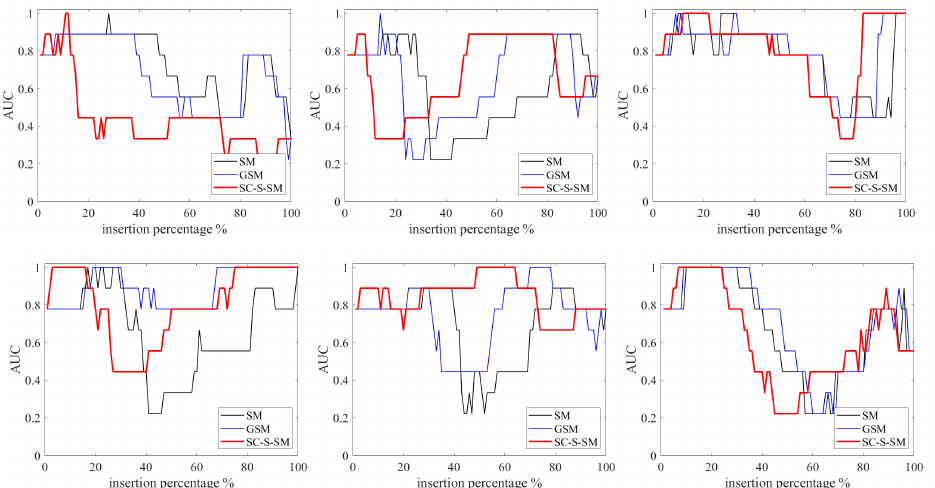
Figure 6. AUC of six representative SAR images, which are calculated by SC-SM CAM with different θ .